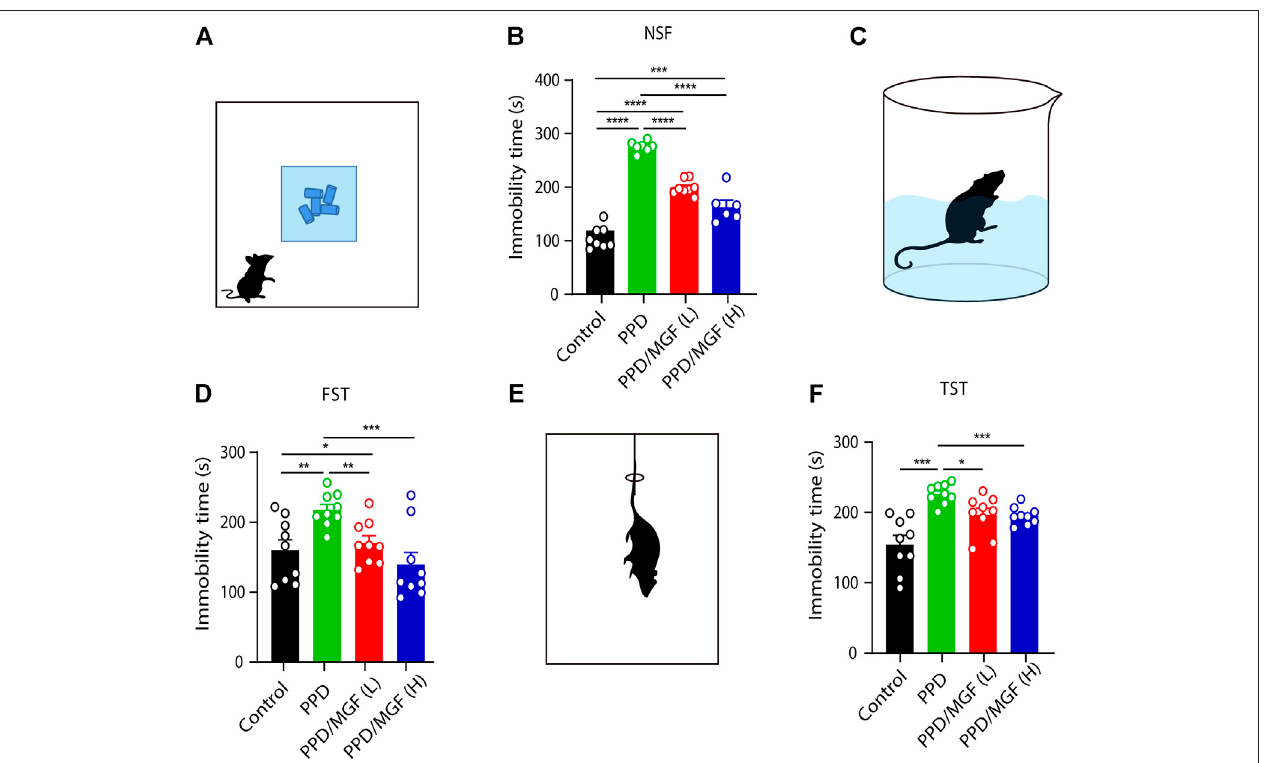
FIGURE2| MGF-alleviatedHSP-induceddepression-likebehaviorinmice. (A) Schematicrepresentationofthenoveltysuppressedfeedingtest(NST). (B) Analysis of immobility time in the NST [control, n = 8, PPD, n = 7, PPD/MGF (L), n = 8, and PPD/MGF (H), n = 6]. (C) Schematic representation of the forced swim test (FST). (D) AnalysisofimmobilitytimeintheFST,n=9ineachgroup. (E) Schematicrepresentationofthetail-suspensiontest(TST). (F) AnalysisofimmobilitytimeintheTST,n=9in each group; Error bars are mean ± S.E.M. * p < 0.05, ** p < 0.01, and *** p <